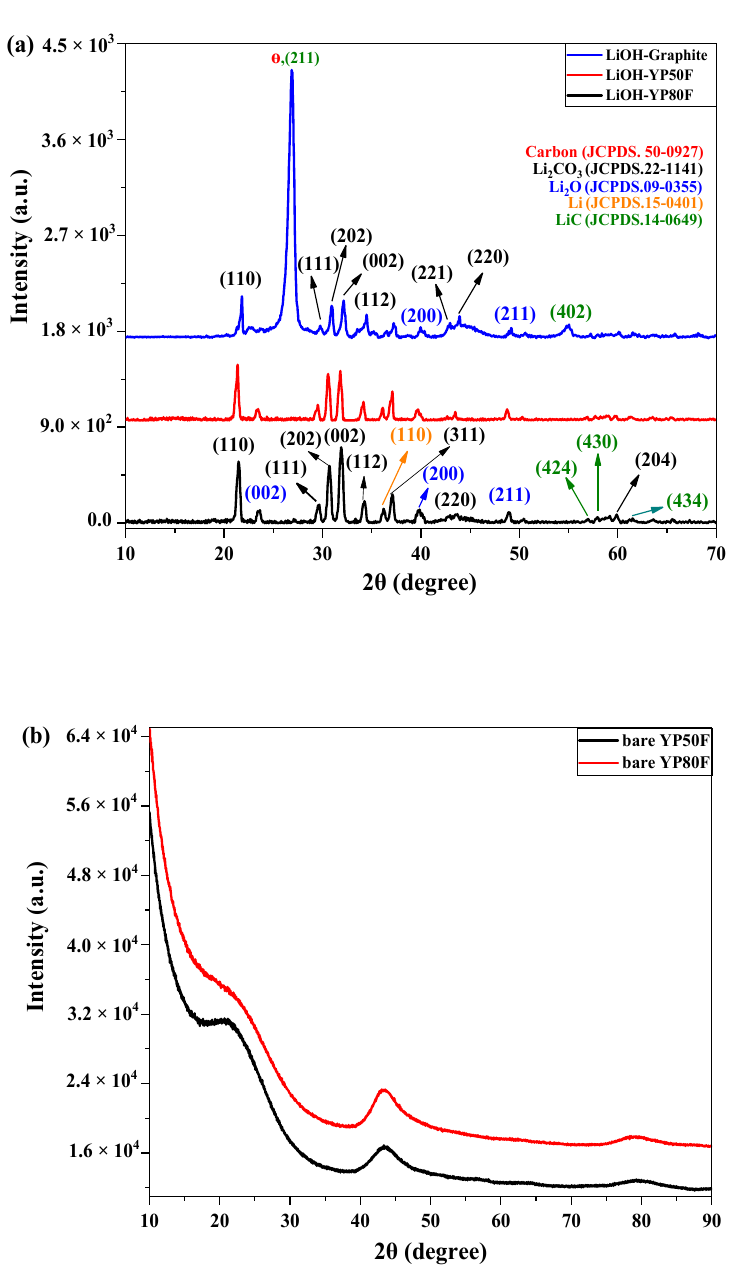
Figure 1. XRD result of ( a ) LiOH-treated YP80F, YP50F and graphite, ( b ) bare YP80F and YP50F. The XRD pattern of Li-Graphite exhibited one sharp peak at 26.78 ◦ , which is a member of graphite and lithium carbide. XRD graphs of the pure YP50F and YP80F are displayed in Figure 1b. Comparison of these results revealed the lithium-carbon nature of the Li-HSAC samples, which confirmed the successful synthesis of the final